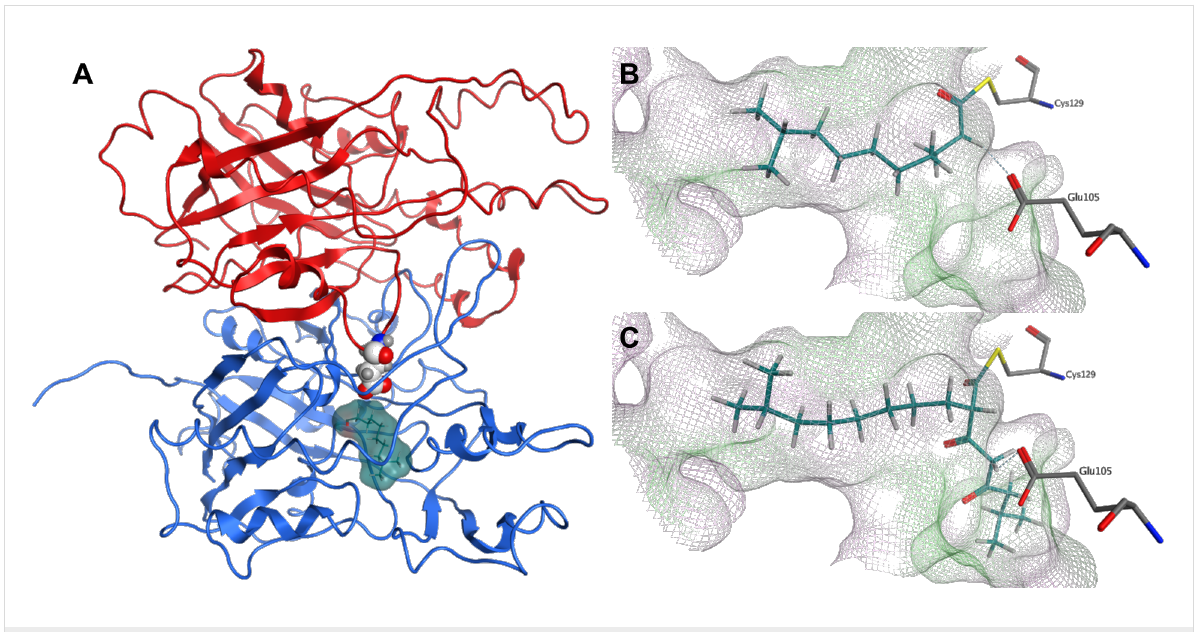
Figure 2: Dimeric structure of modeled PpyS (A). Chain A (blue), chain B (red). 14 (surface, cyan) is covalently docked to the active site at Cys129 α and the atoms of Glu105 β are represented as white spheres. Glu105 is proposed to act as a catalytic base. A detailed view of the proposed PpyS- binding pocket with covalently docked 14 (B) and 16 (C), respectively. The cavity of the binding pocket is shown in a line representation, where green represents a lipophilic, magenta a hydrophilic and white a neutral surface area. Possible hydrogen bonds are shown as dashed blue